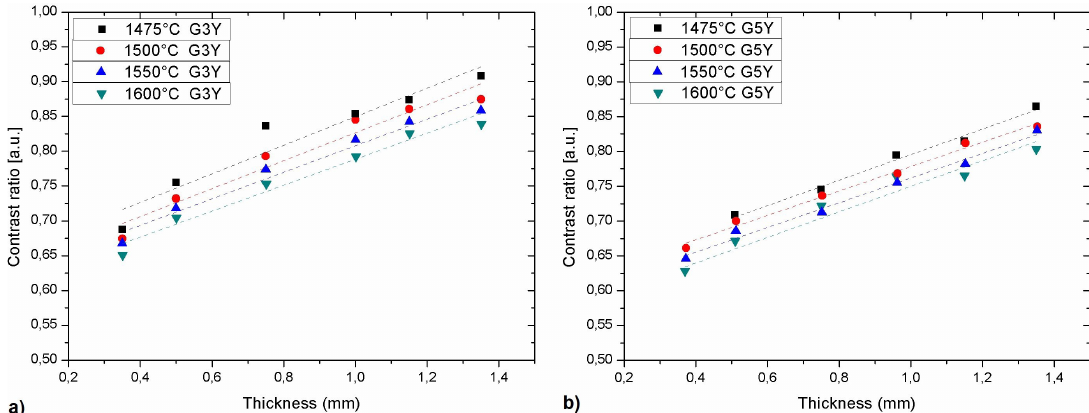
O , depending on the thickness: a) G3Y and b) 2 3